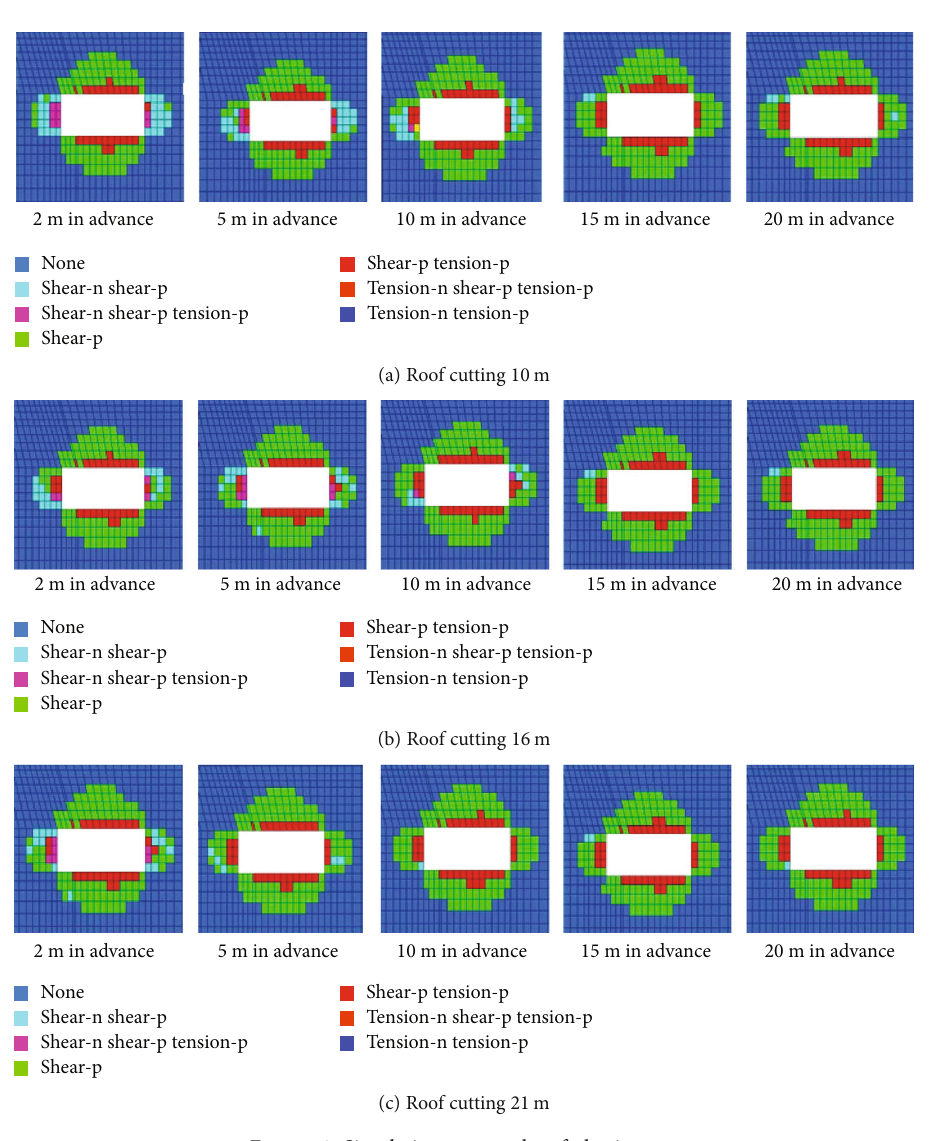
Figure 9: Simulation test results of plastic